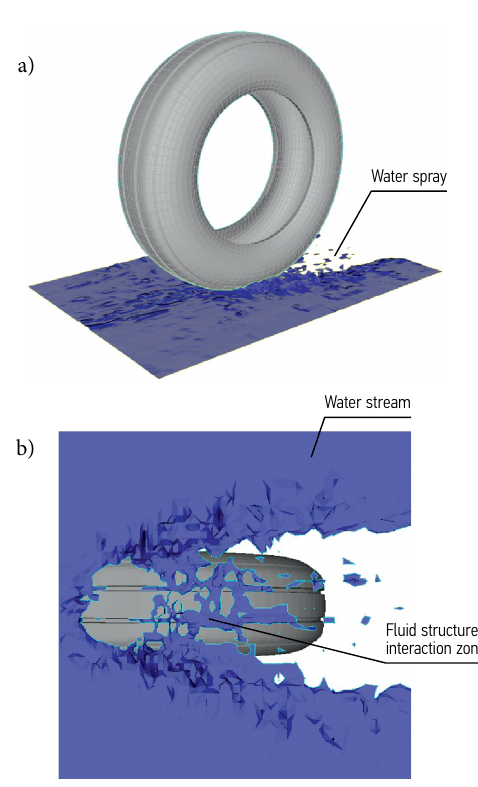
Fig. 6. Tire hydroplaning results: a – isometric view; b – bottom view